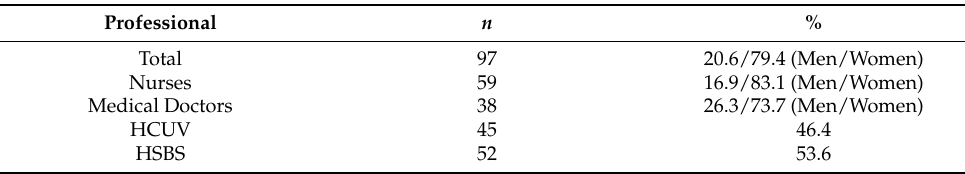
Table 1. Group numbers and percentages.